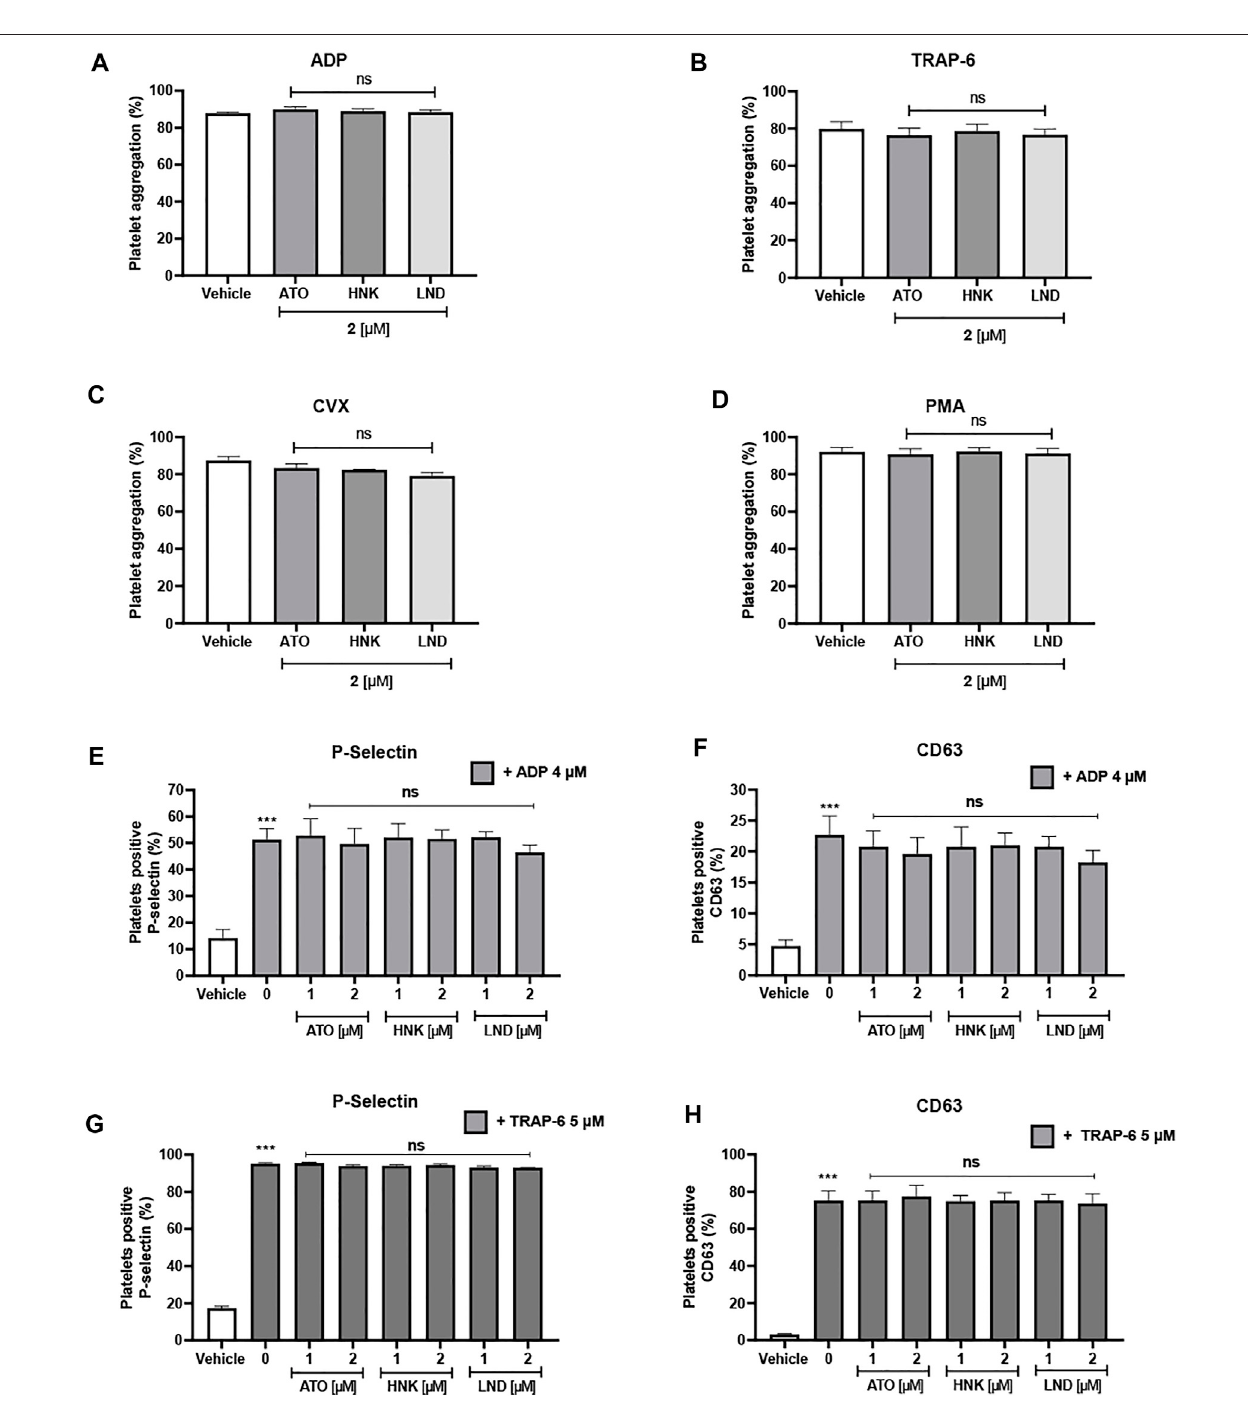
FIGURE4| Lackofeffectofthecompoundsuponplateletaggregationandplateletactivationmarkers.Plateletaggregationisinducedby (A) ADP, (B) TRAP-6, (C) convulxin,and (D) PMA.P-selectinexpression (E) andCD63expression (F) onplatelet-richplasmastimulatedwithADP.P-selectinexpression (G) andCD63expression (H) onwashedplateletsstimulatedwithTRAP-6.Plateletswereidenti fi edasCD61 + populationandtheseCD61-expressionswereanalyzedintermsofthepercentageof positive platelets to the activation marker. The results were expressed as mean ± SEM. Vehicle: DMSO 0.4%. The statistical analysis was performed using a one- way analysis of variance (ANOVA) and the Bonferroni post hoc test. p p < 0.05; pp p < 0.01 and ppp p < 0.001 vs. vehicle, ns: not signi fi cant vs. 0 (E – H) .